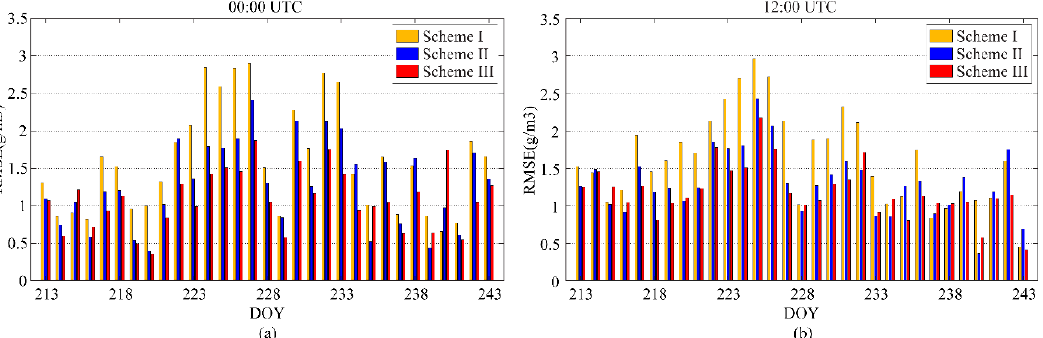
Figure 16. Comparisons of the RMSE of the tomography results derived from different schemes during the 31-day period from DOY 213 to DOY 243, 2017, at (a) 00:00 UTC and (b) 12:00 UTC daily. Table 6. Statistics (RMSE, STD, and bias) of the tomography results for the three schemes (unit: g/m 3 ).